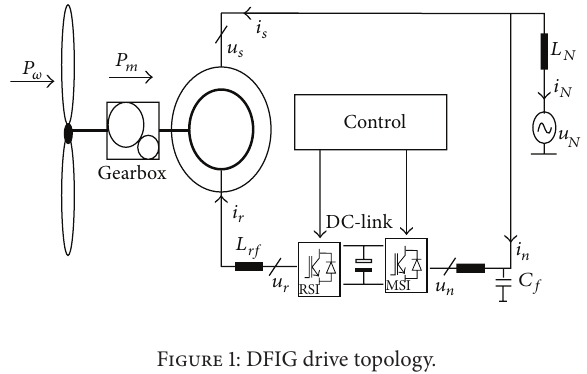
Figure 1: DFIG drive topology.